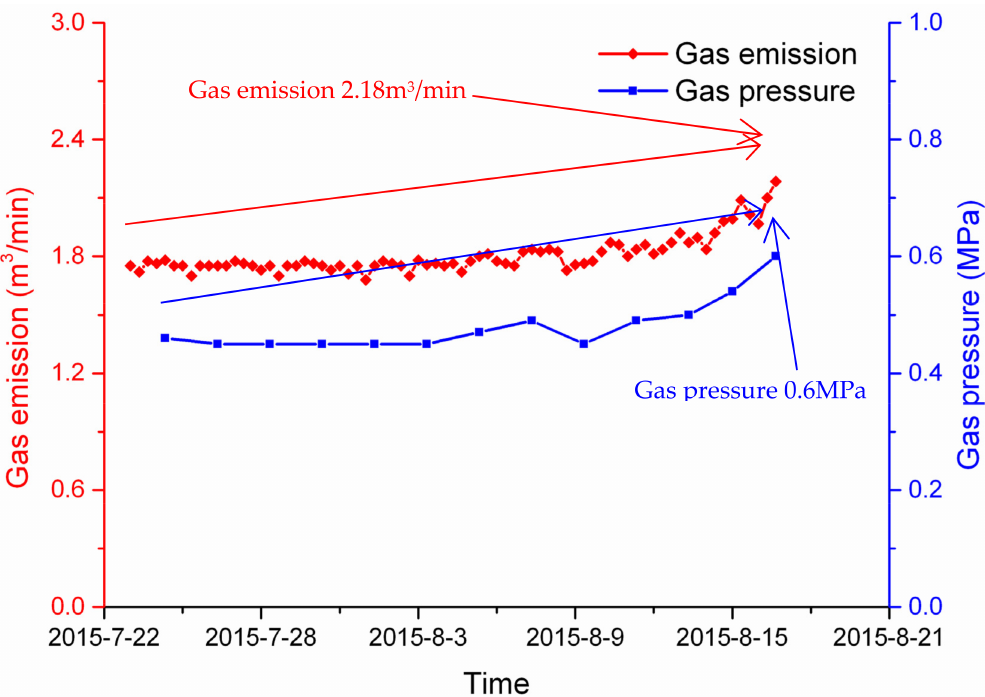
Figure 6. Gas pressure using the prediction model before the dynamic phenomenon occurred.